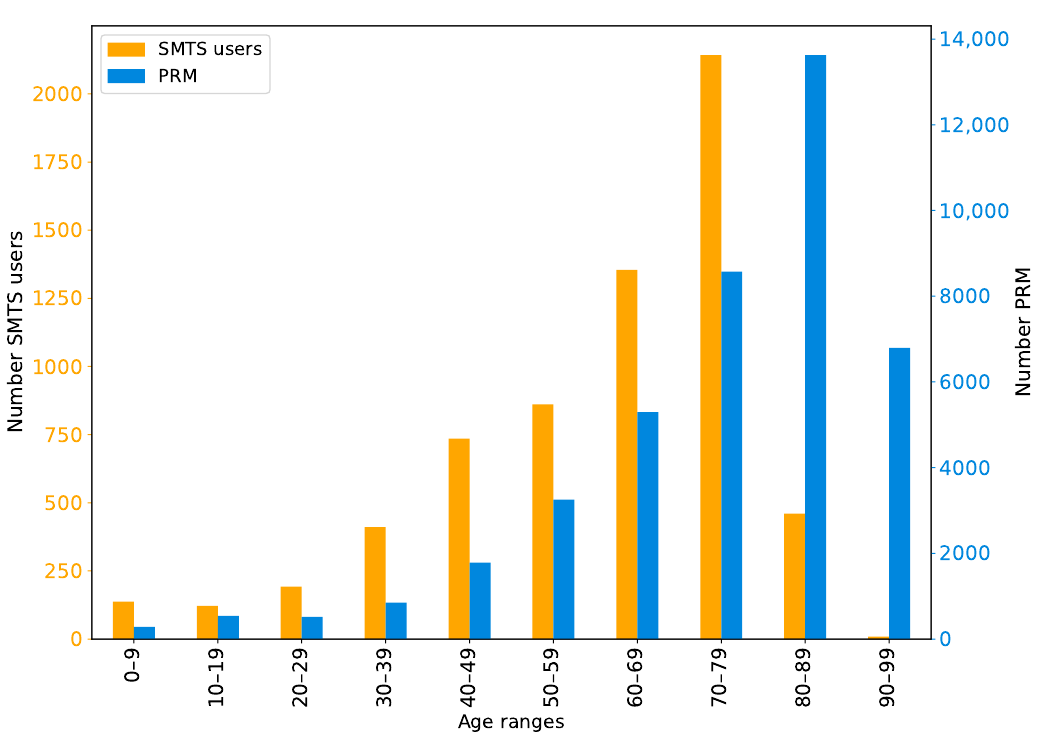
Figure 2. Age distribution and comparison between SMTS users and PRM. Orange bars (primary axis) represent SMTS data, while blue bars (secondary axis) represent PRM